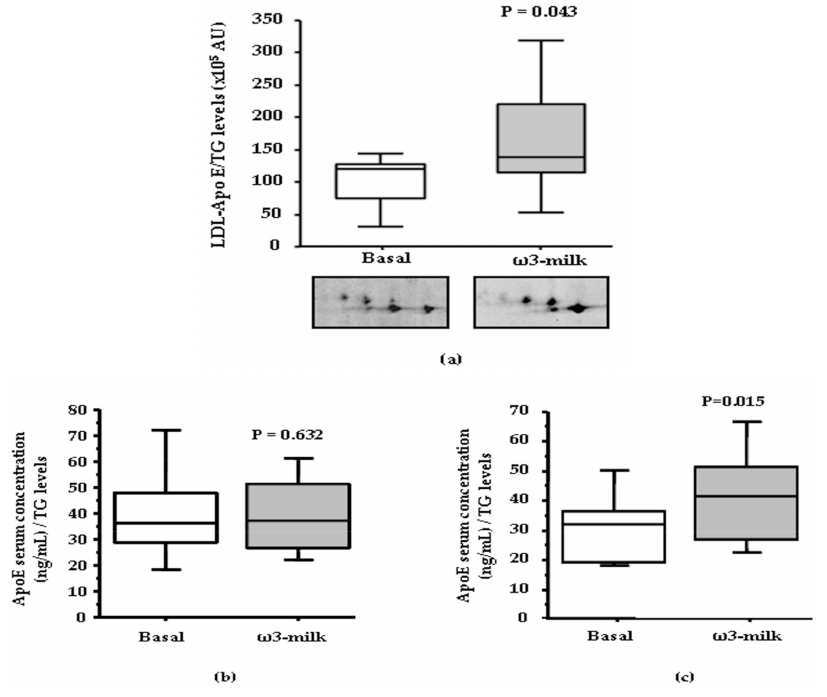
Figure 2. Changes in the apolipoprotein (Apo) E profile. ( a ) Box-Plot diagram and representative 2-DE images showing the low density lipoprotein (LDL)-associated Apo E proteomic profile before and after the intake of ω 3-milk. A significant increase of Apo E levels ( p = 0.043) is observed. Box-Plot diagrams showing serum Apo E levels (ng/mL) in basal conditions and after 4-weeks intervention with ω 3-milk, measured by a commercial ELISA. No change was observed when all the volunteers were analyzed (( b ); N = 32; p = 0.105). Apo E concentration of subjects with reduced triglyceride (TG) levels showed a significant increase after ω 3-milk intake (( c ); N = 11; p =